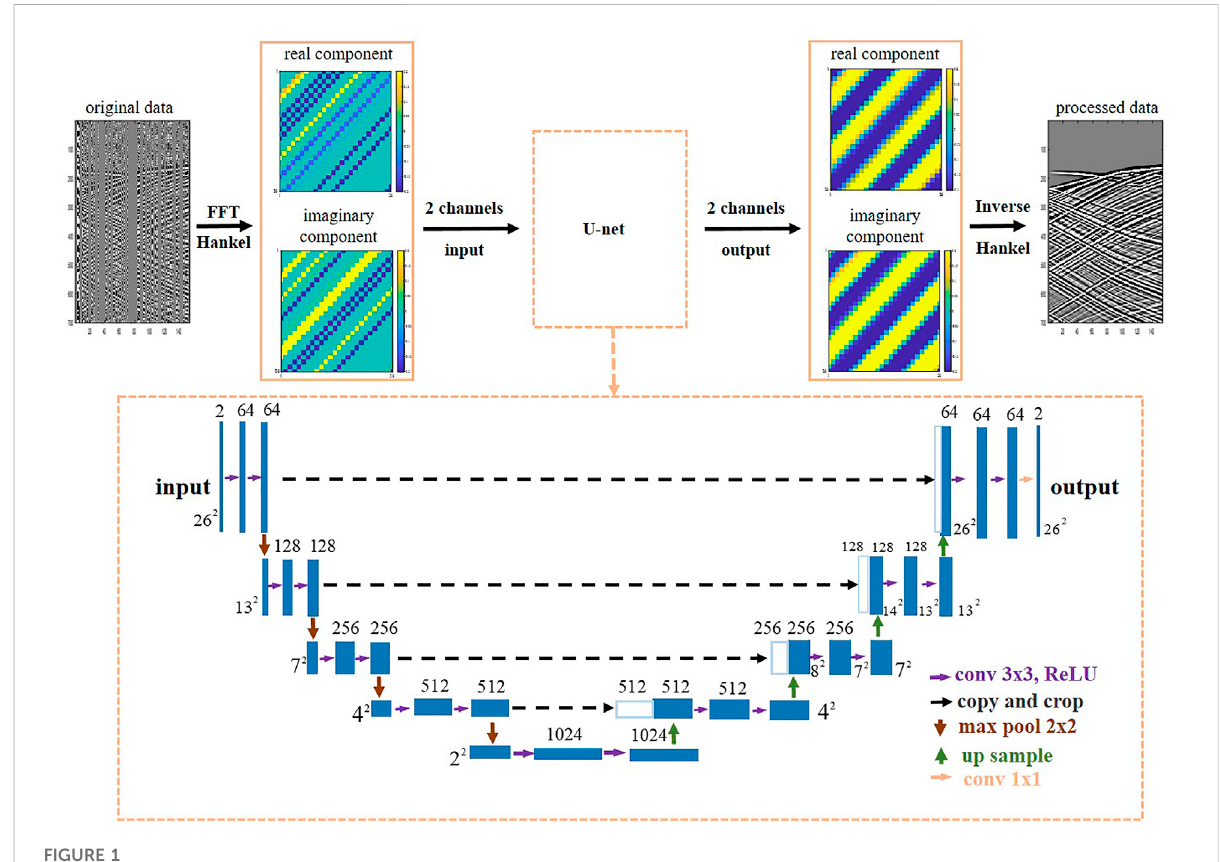
FIGURE 1 Architecture of the RRU-net.